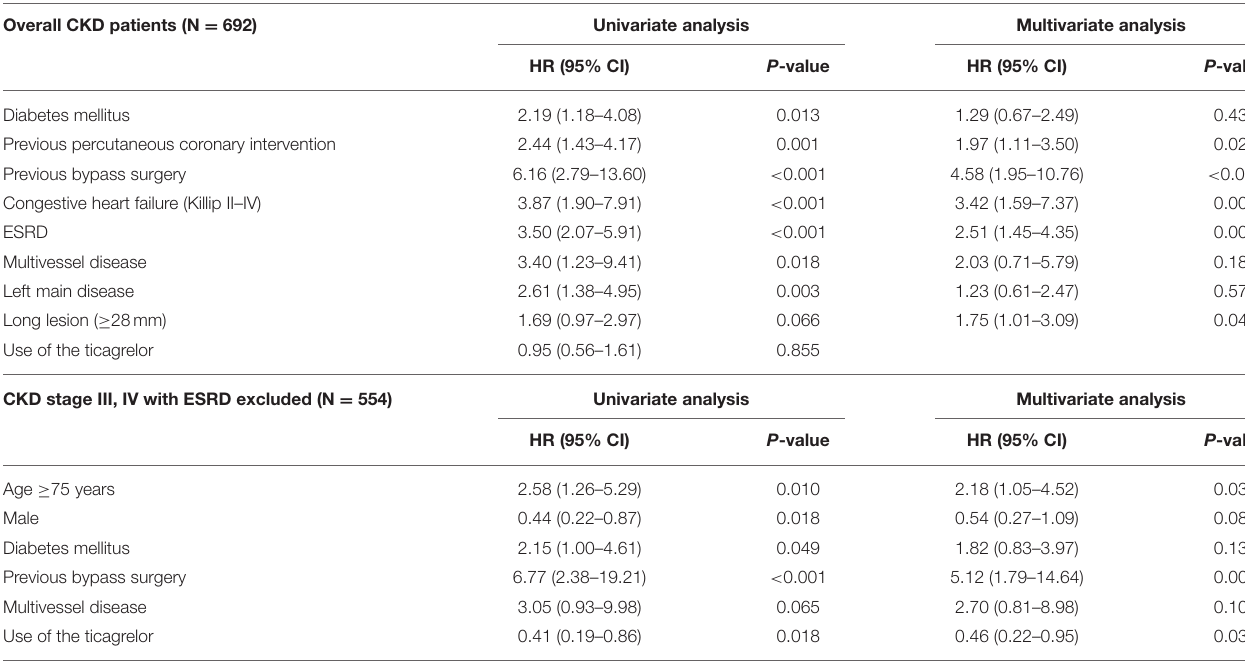
TABLE 3 | Predictors for the occurrence of major adverse cardiac and cerebrovascular events. Overall CKD patients (N =